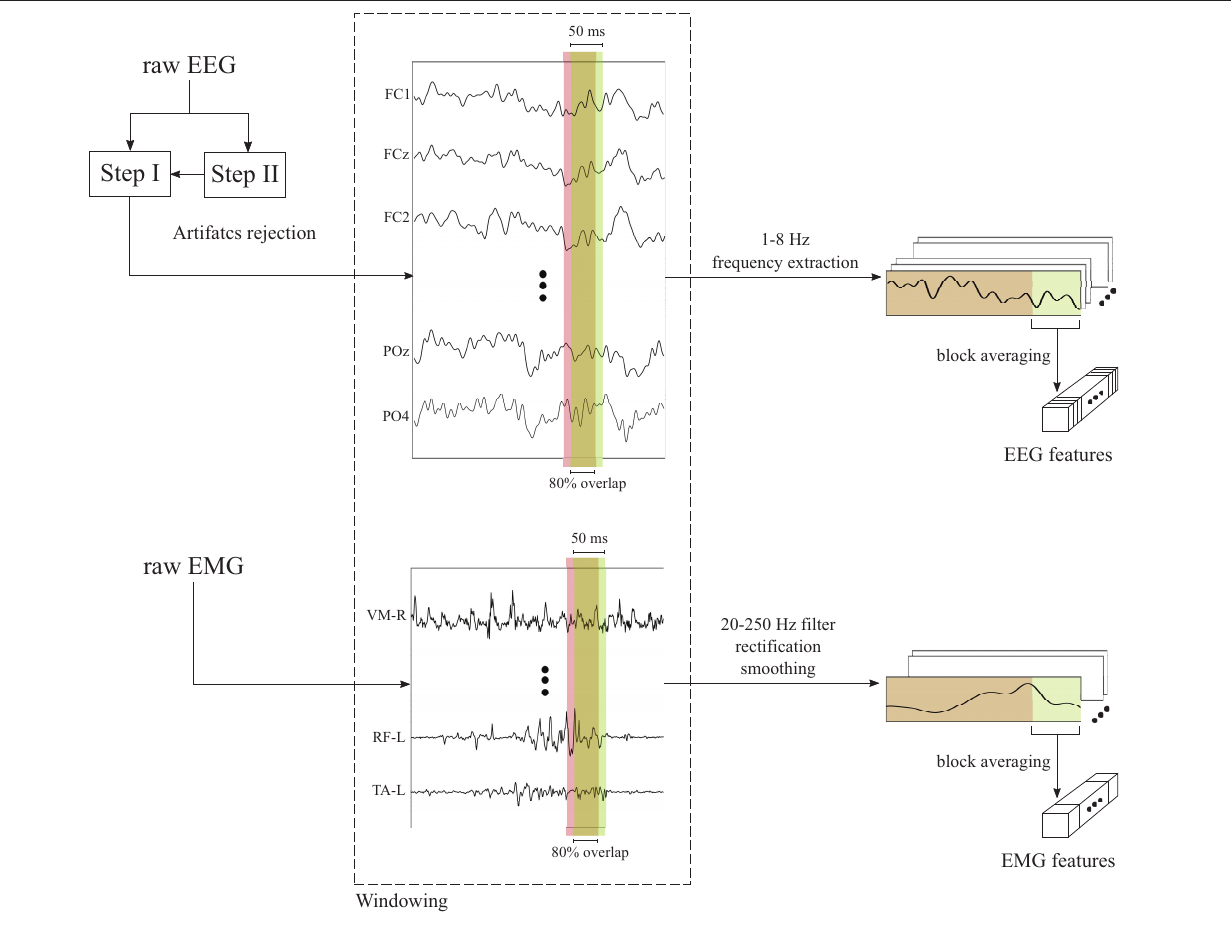
FIGURE 2 | Schematic representation of the preprocessing procedures applied to the EEG and EMG signals. EEG signals are firstly preprocessed with a two-step preprocessing to reject motion artifacts. Then, EEG and EMG time series are segmented in time windows of 50 ms with 80% overlap. After the windowed signals are further processed, the non-overlapping samples of each window (i.e., the last 20%) are block averaged in order to obtain a single EEG or EMG features per